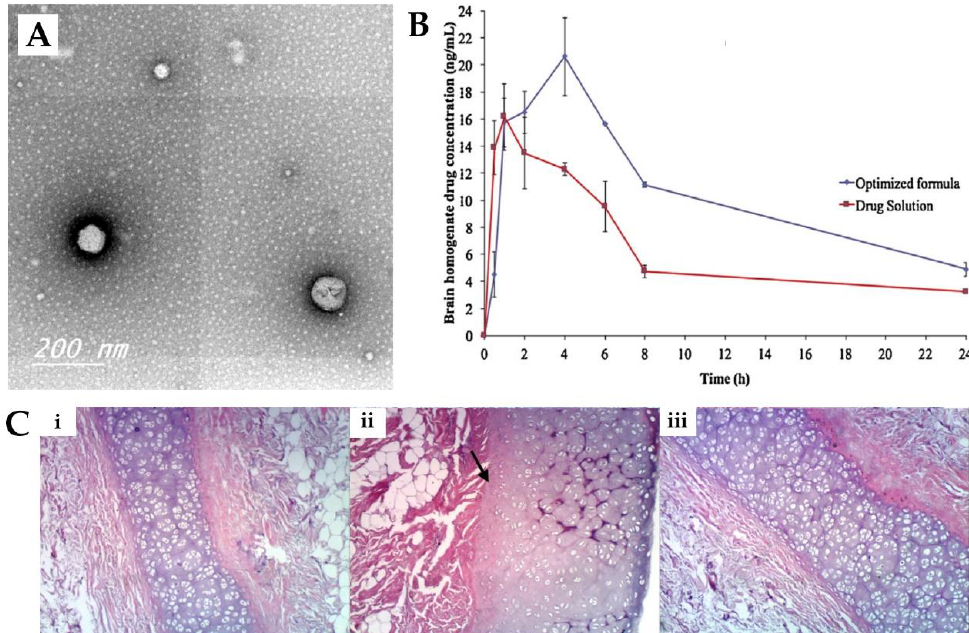
Figure 3. ( A ) Transmission electron microscopy micrographs of the developed risperidone spanlastics; ( B ) Brain concentration vs time profiles of the intranasal risperidone spanlastics (“optimized formula”) and intranasal risperidone solution (“drug solution”); ( C ) Nasal sheep mucosa histopathological evaluation of the developed risperidone spanlastics ( iii ), compared to normal saline (negative control, ( i )) and isopropyl alcohol (positive control, ( ii )); adapted from Abdelrahman et al. [98], reproduced with permission from Elsevier [License Number 5477081208011].